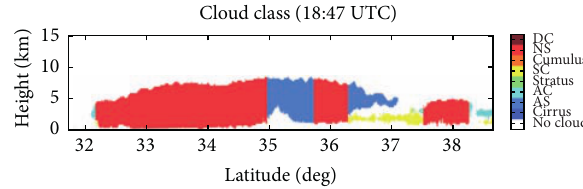
Figure 3: The cloud classification determined from CloudSat CPR.